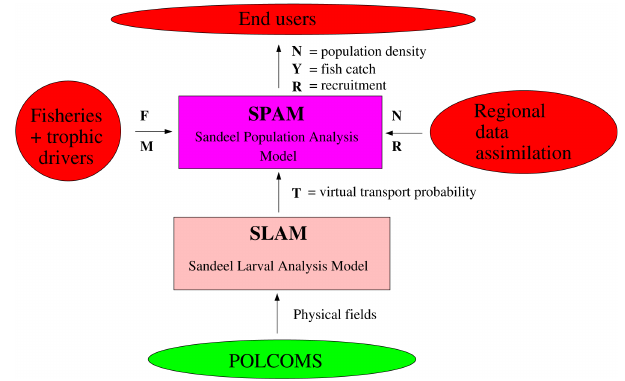
Fig. 2. Diagram of coupled model